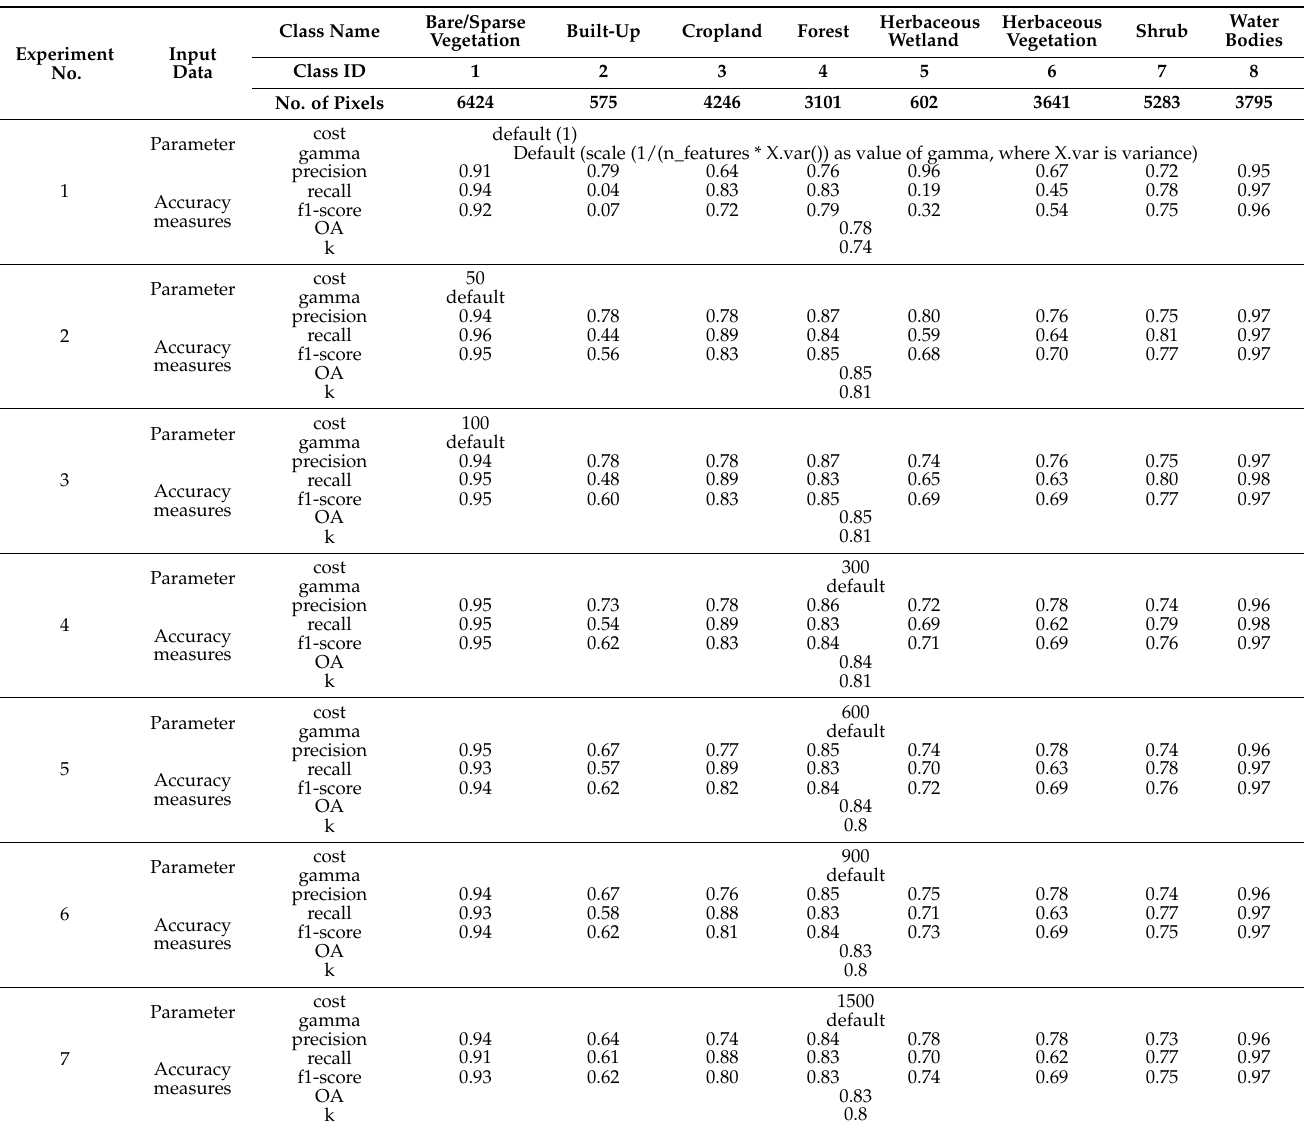
Table 5. Accuracy of the various SVM